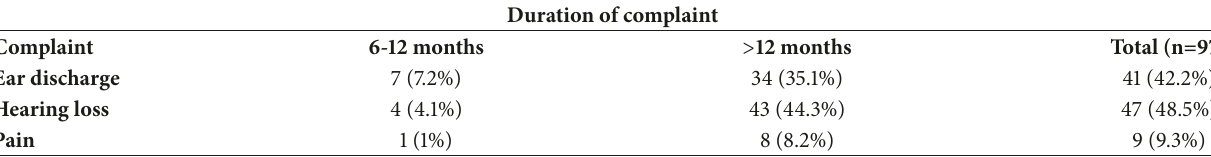
Table 3: Patients’ complaint and duration.